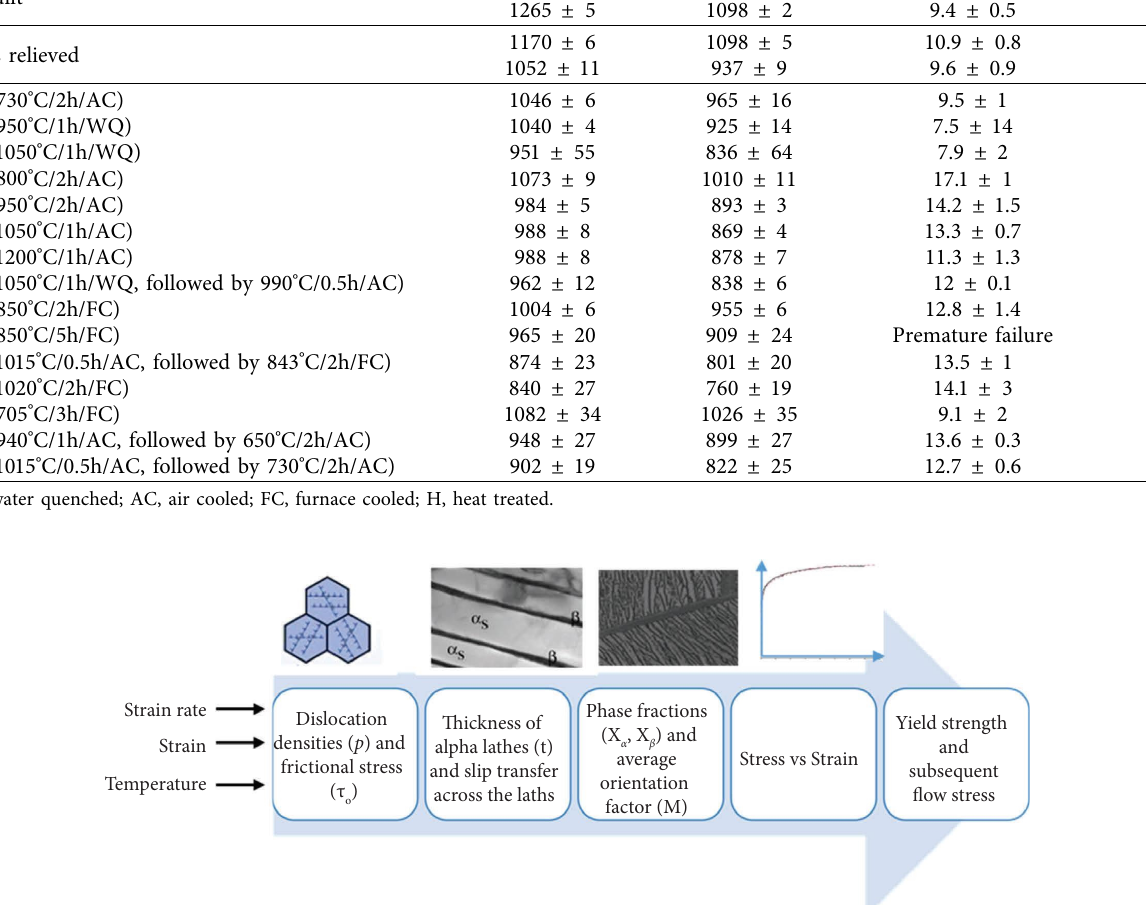
Figure 1: A fow diagram of the proposed microstructural variable-based model for predicting the mechanical properties of various forms of DMLS Ti6Al4V (ELI) alloy